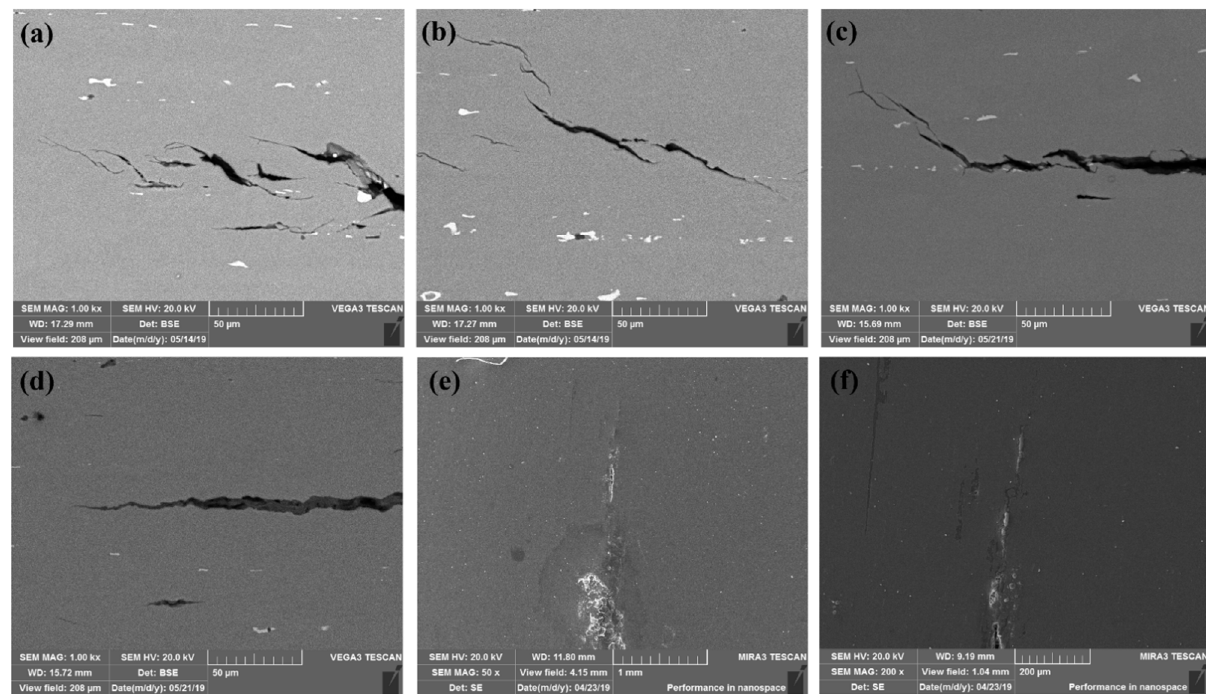
Figure 4. SEM images of the localized corrosion and SCC microstructures: ( a – c ) the discontinuous cracks in the SCC propagation paths together with pits and precipitations; ( d ) the crack tip; ( e , f ) the pitting and the IGC.